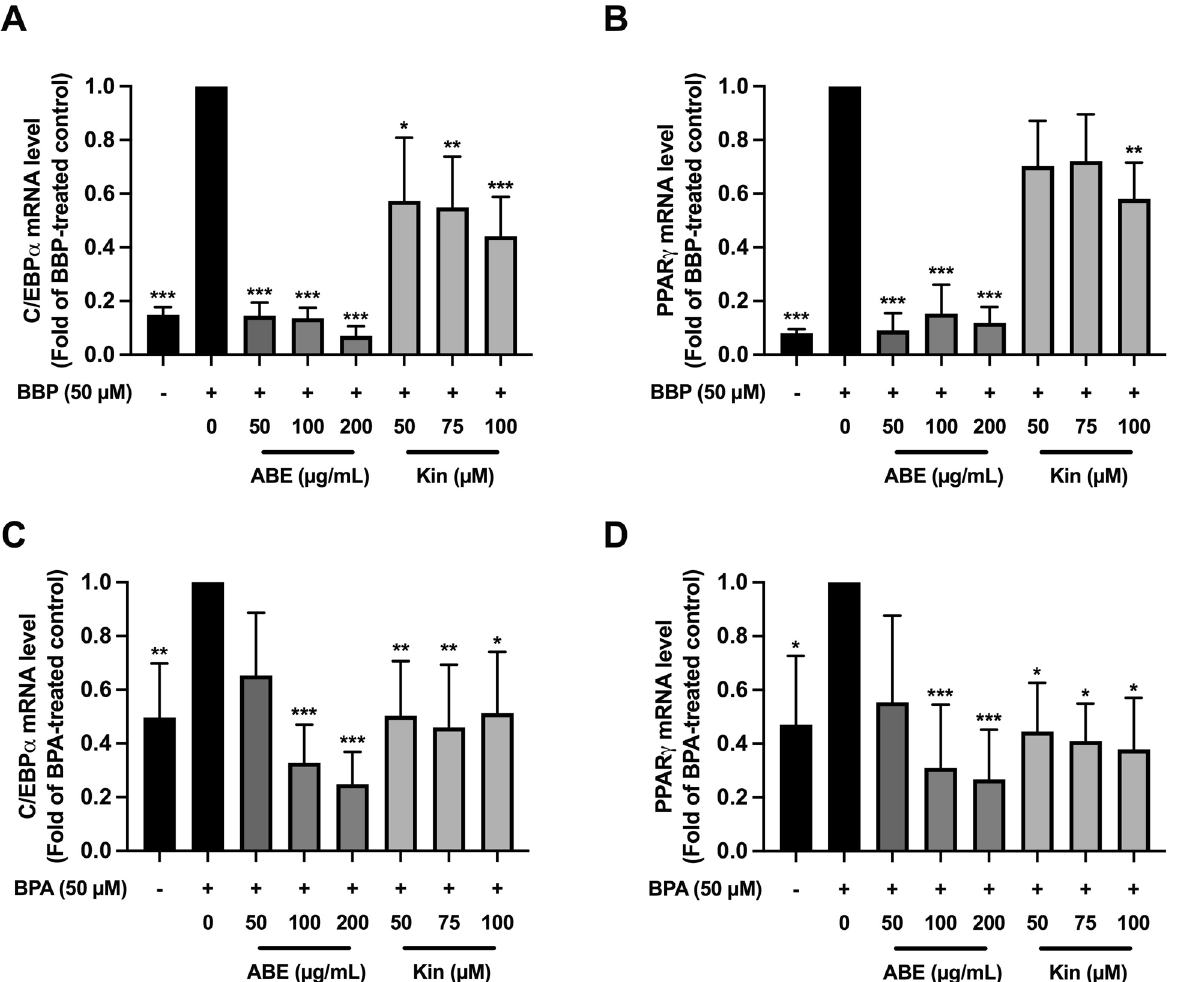
Figure 3. The effect of ABE or Kin on obesogen-induced adipogenic gene expression in 3T3-L1 cells determined by RT-qPCR. C/EBPα ( A , C ) and PPARγ ( B , D ) mRNA level in the cells treated with ABE or Kin in the presence of BBP or BPA (50 µM). The data indicated as mean ± SD of three independent experiments * p < 0.05, * p < 0.01 and *** p < 0.001, compared to obesogen-treated